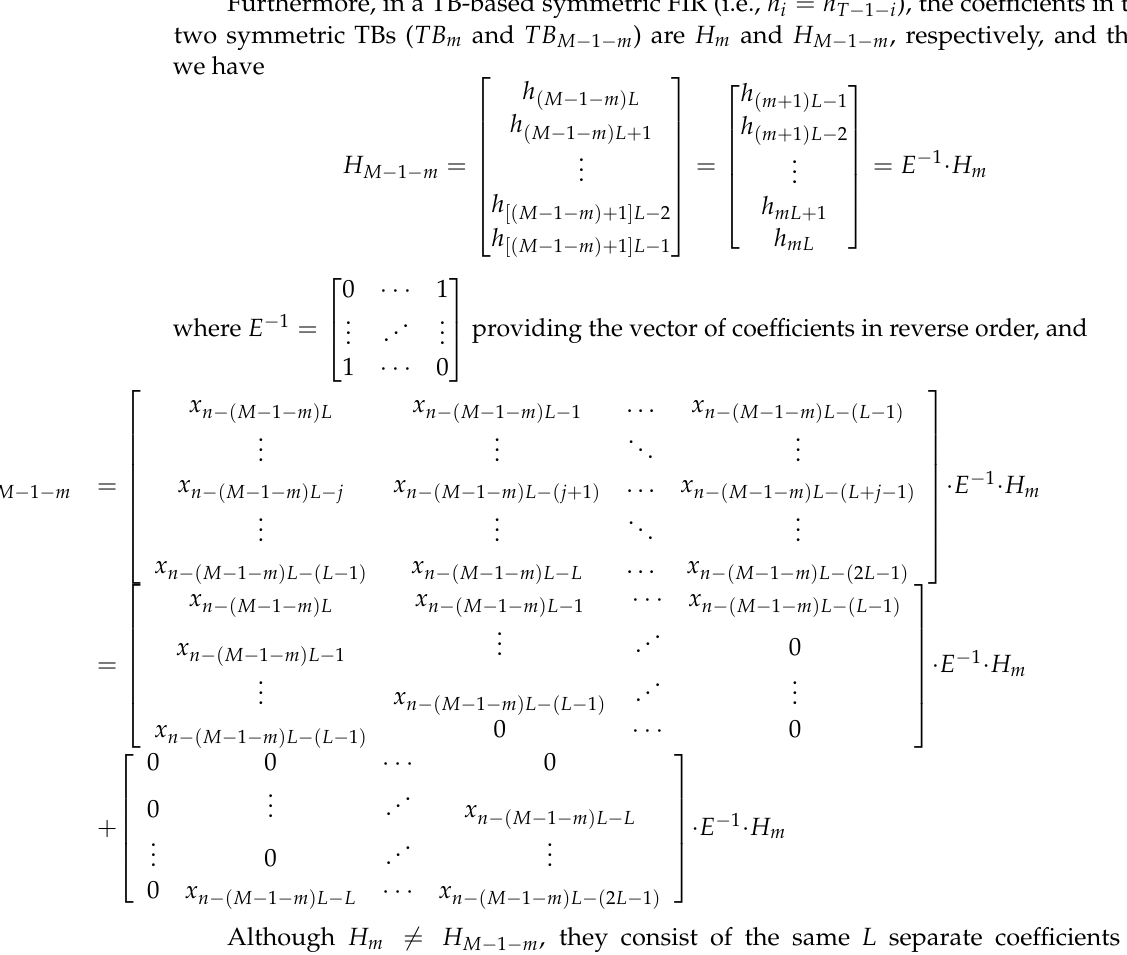
Figure 5. Combined implementation of the two circuits shown in Figure 4.